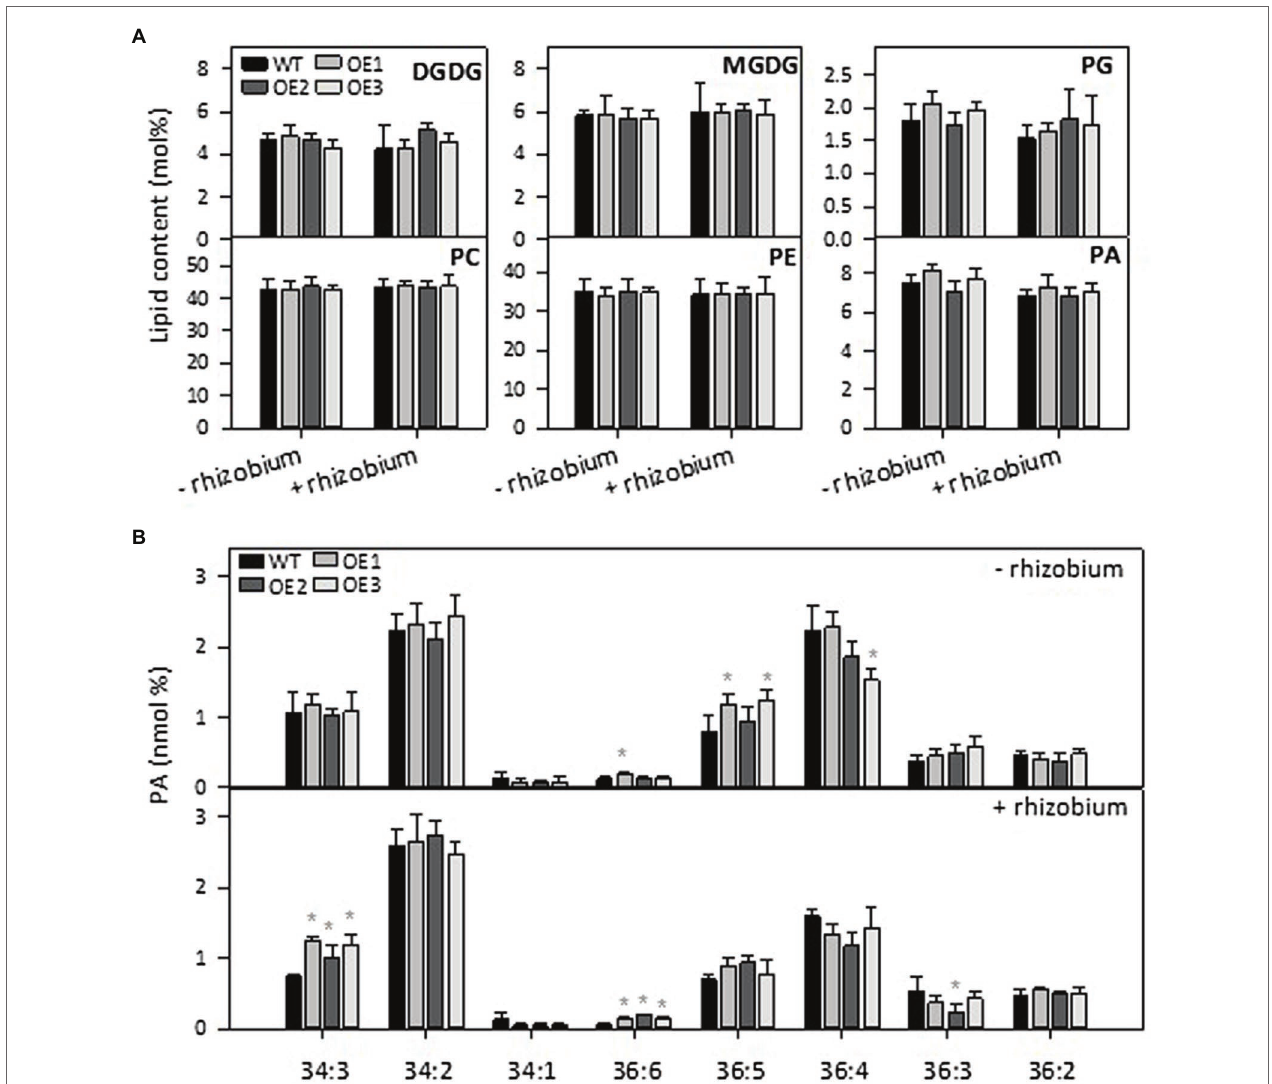
FIGURE 5 | Effect of PLD ε alterations on lipid content under nitrogen deficiency with or without nodulation. (A) Lipid contents in roots of WT and AtPLD ε OE soybean plants under nitrogen-deficient conditions. Three-week-old soybeans grown on vermiculite supplied with 0.6 mM N were infected with Bradyrhizobium diazoefficiens USDA110 and maintained for 28 days. The values are means ± SD of four biological replicates. *Denotes statistical significance at p < 0.05 compared with WT as determined by one-way ANOVA (Duncan’s multiple range test). (B) PA molecular species in roots of WT and AtPLD ε OE